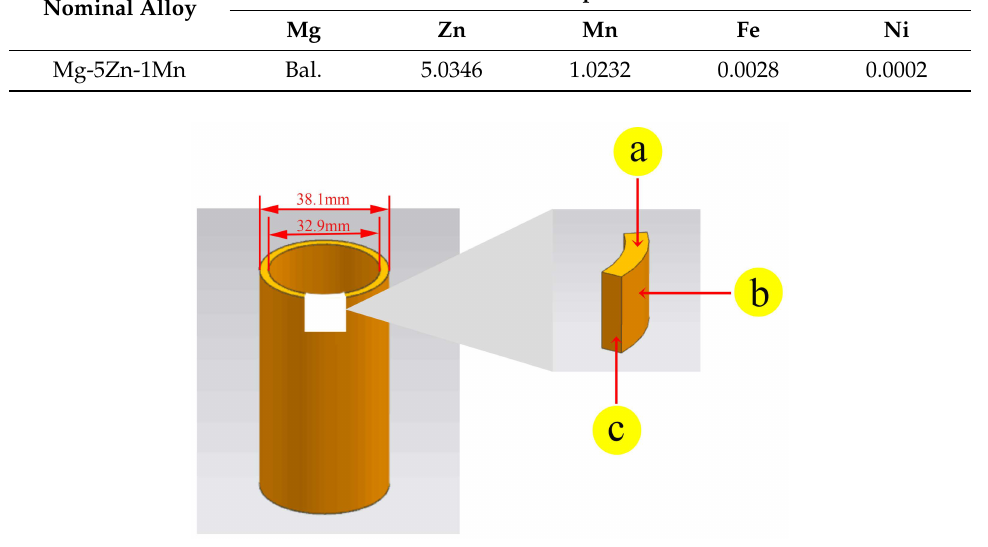
Figure 1. The ZM51 alloy tube size and sample diagram: ( a ) cross section, ( b ) outside surface and ( c ) longitudinal section. Table 2. Heat treatment parameters for the ZM51 alloy tube.